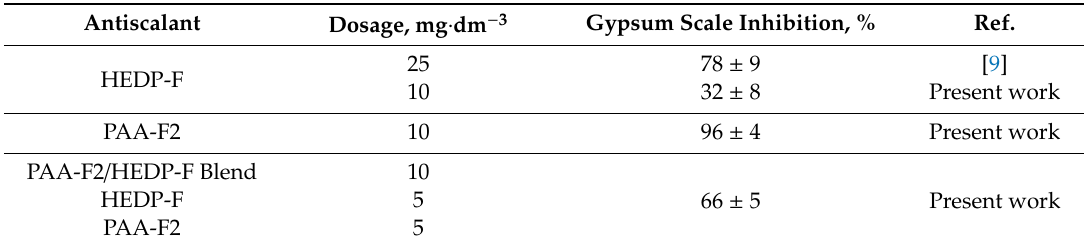
Table 2. Gypsum scale formation inhibition efficacy of fluorescent-tagged antiscalants tested by the NACE Standard.